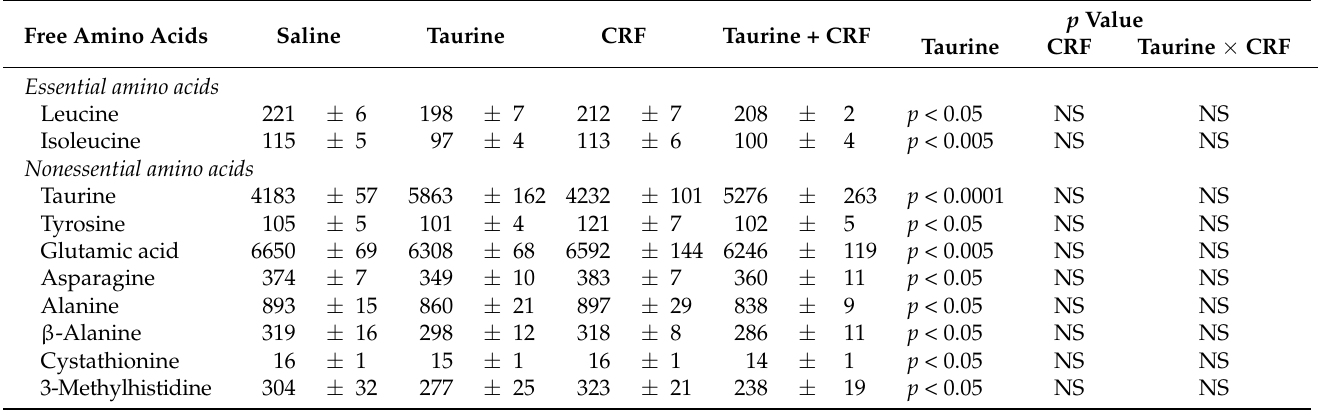
Table 1. Effect of the intracerebroventricular injection of taurine or CRF on the amino acid concentra- tions in the diencephalon of chicks exposed to social isolation stress.